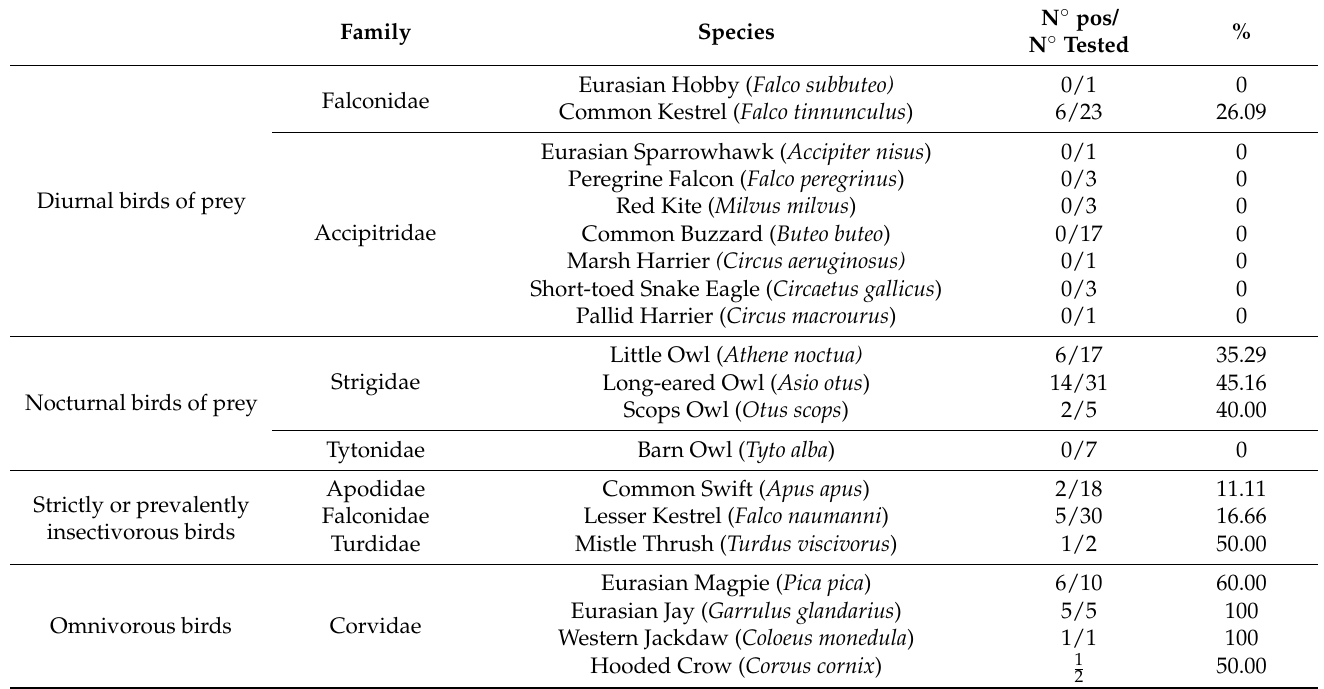
Table 3. Detection of Campylobacter in wild birds housed in the rescue